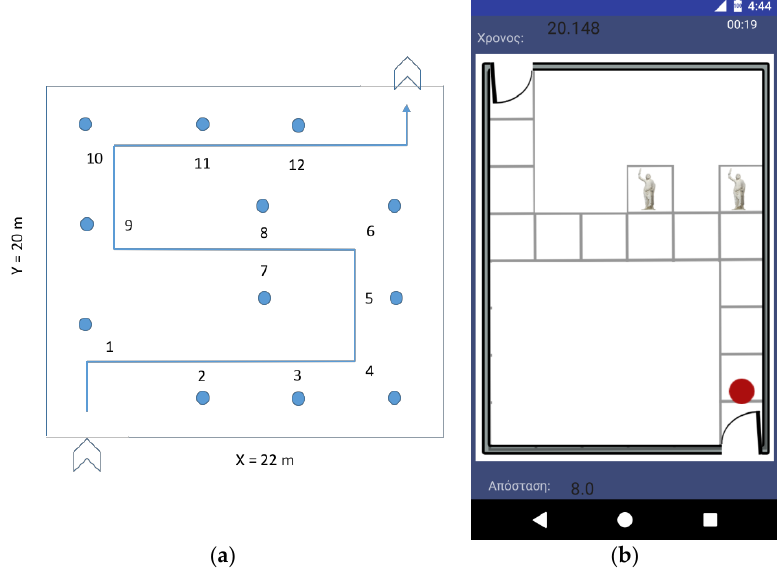
Figure 4. ( a ) Floor plan of a museum room with a surface-mounted tactile guiding linear route of a self-guided tour; ( b ) Android implementation of the concept.